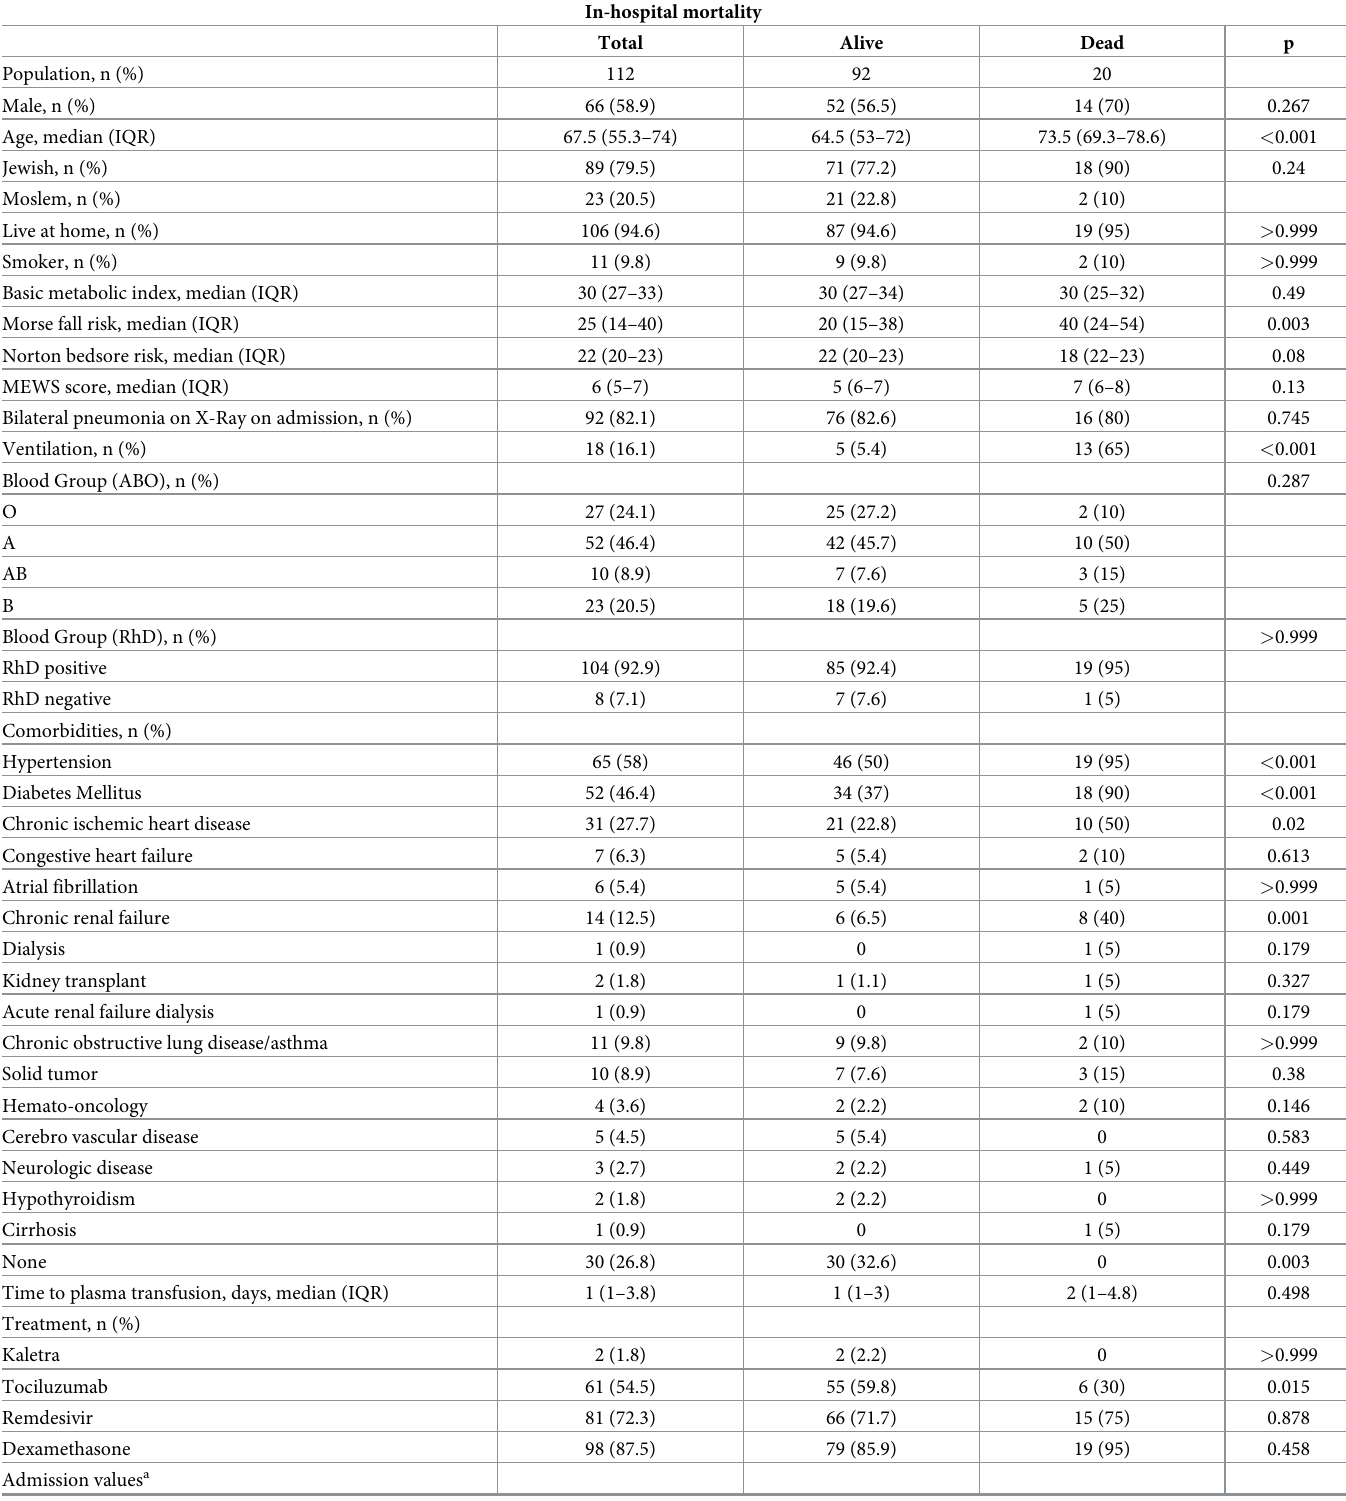
Table 1. Patients receiving convalescent Covid